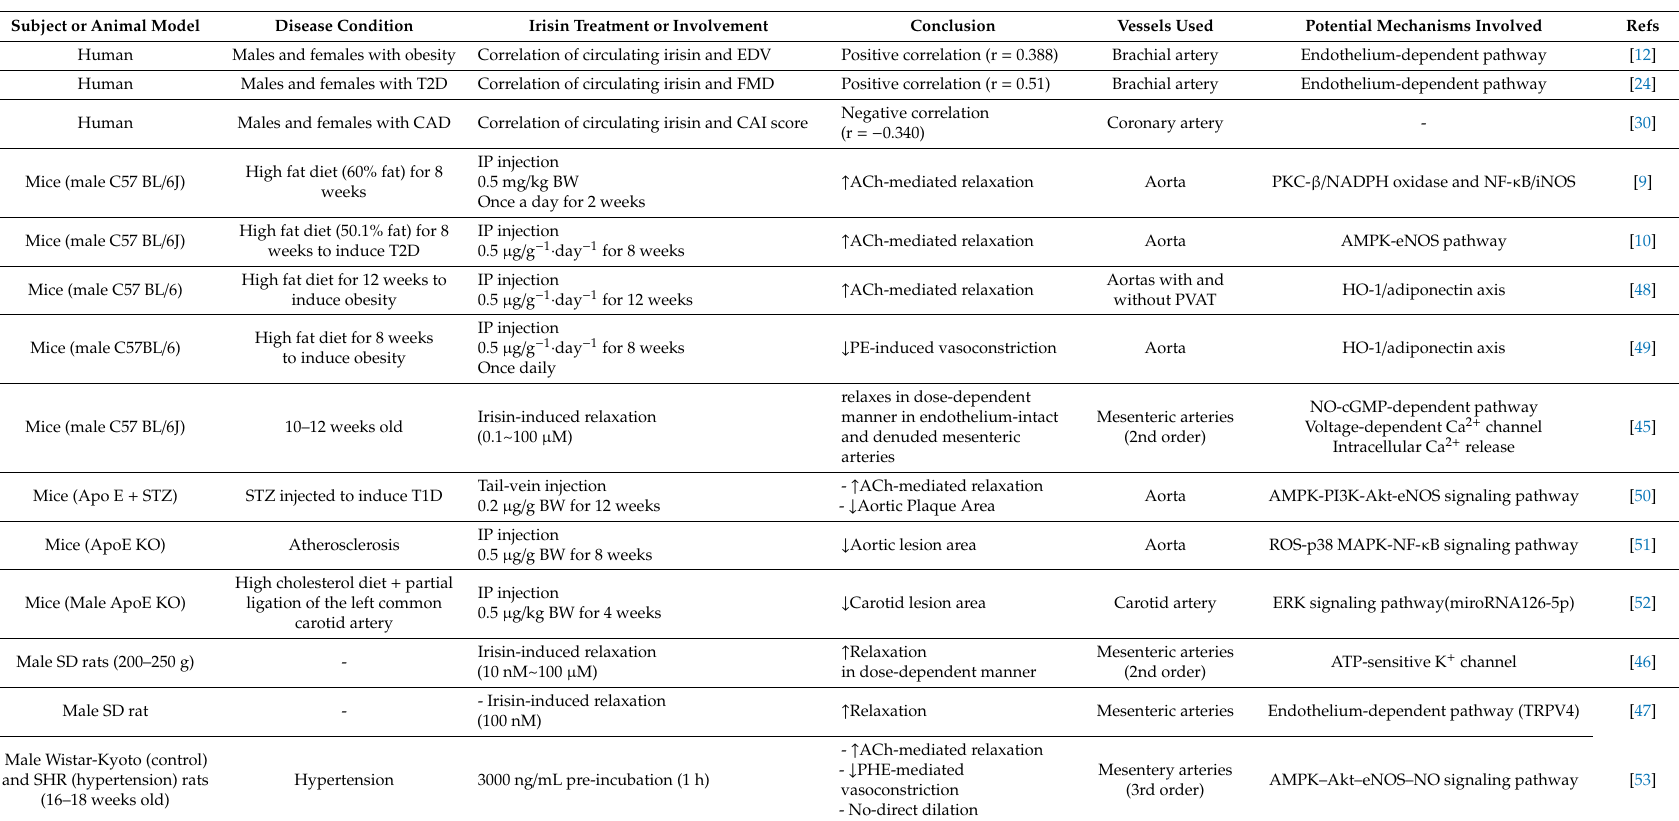
Table 2. The role of irisin in vascular function and atherosclerosis, and potential mechanisms